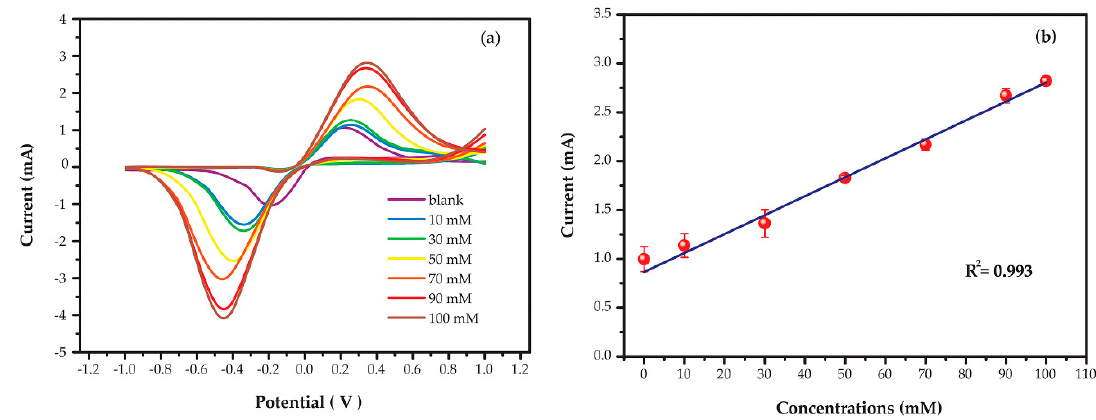
Figure 6. ( a ) Cyclic voltammograms and ( b ) relative anodic peak currents of AgNPs/GO/SPE sensors in different sodium concentrations at a scan rate of 100 mV s − 1 .